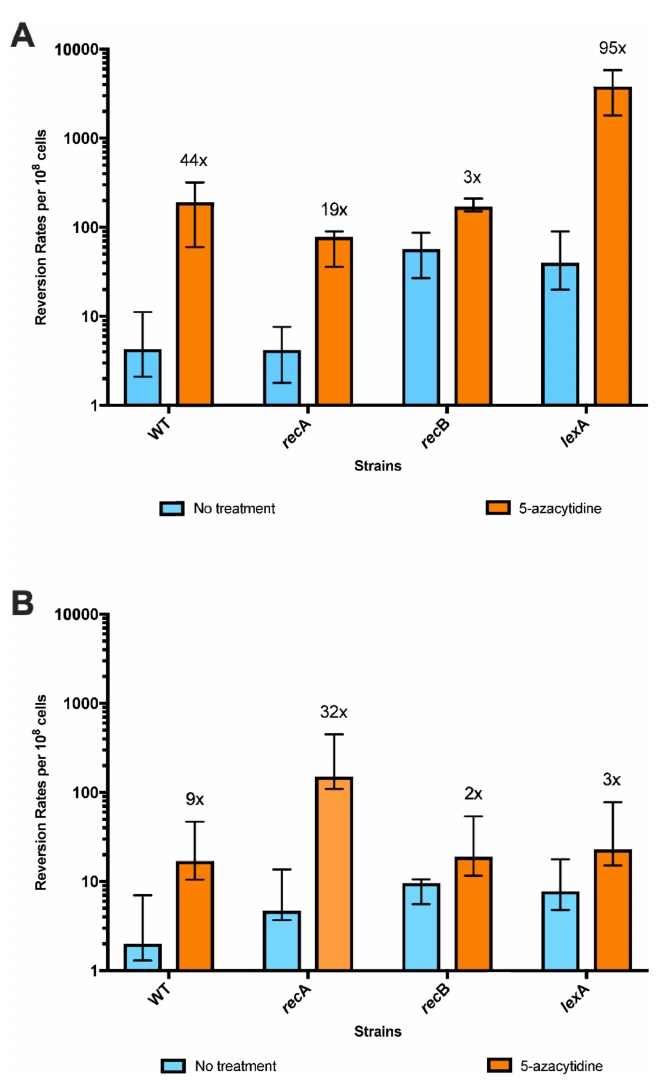
Figure 5. Reversion rates of lacZ QP5 and QP6 recA , recB , and lexA3 mutational reporters after treatment with 5-azacytidine. Data show reversion rates per 10 8 cells from at least 6 multiple trials performed on different days. Error bars represent 95% confidence interval. Reversion rates of lac Z QP5 recA , recB , and lexA3 mutant strains with and without exposure of 12.5 ug/mL of 5-azacytidine. ( A ) Rates for QP5 reporters are 4.3, 190, 4.2, 78, 57, 170, 40, and 3800. Fold change comparing rates of reversion before and after exposure are 44, 19, 3, and 95, respectively. ( B ) Rates for QP6 reporters are 2, 17, 4.7, 150, 9.6, 19, 7.8, and 23. Fold change comparing rates of reversion before and after exposure are 9, 32, 2 and 3